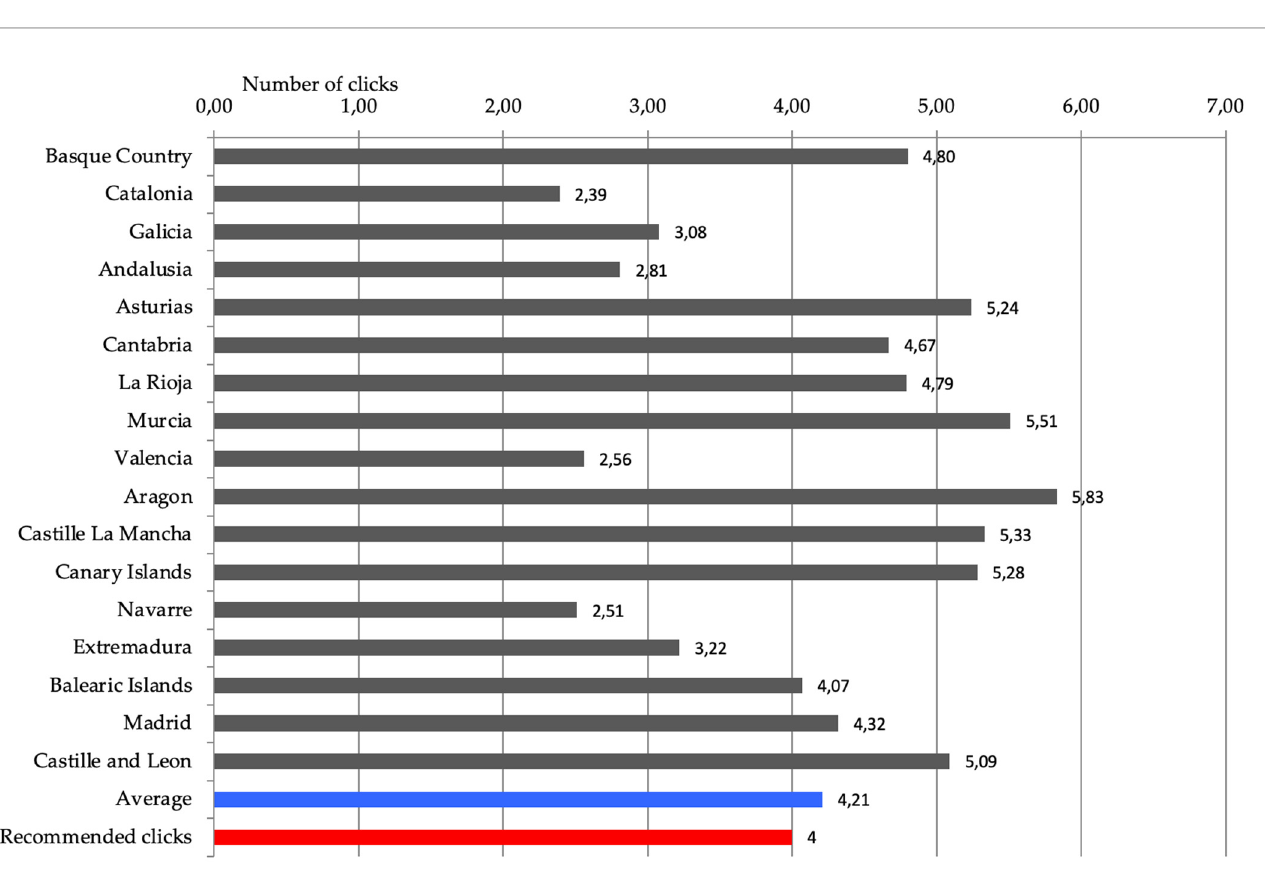
Figure 2. Difficulty in accessing content.